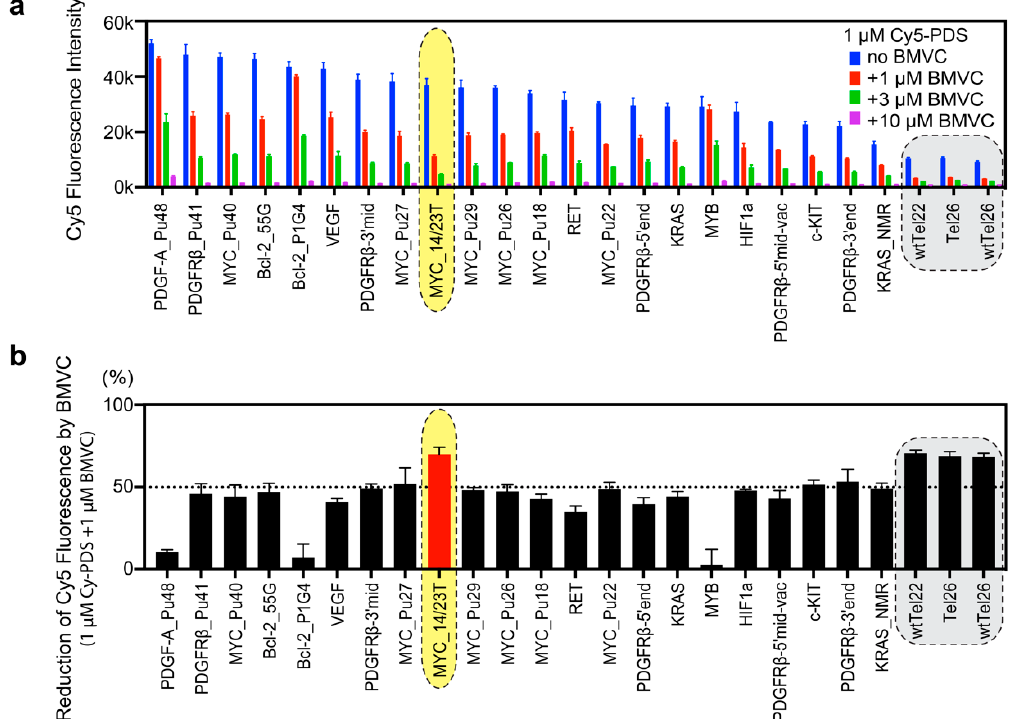
Figure 2. The binding preference of BMVC to known G4 structures. Among the known G4 structures, BMVC prefers to bind to MYC_14/23T, 5 ′ -TGAGGGTGGGTAGGGTGGGTAA-3 ′ (highlighted by yellow shade). Telomeric sequences are known to form nonparallel structures [42–46] and are poorly bound by Cy5-PDS (shaded in gray). ( a ) The competition microarray experiments showing dose-dependent inhibitory effects of BMVC on the binding of Cy5-PDS to various known G4 structures. The G4 sequences are shown in Table 1. n = 2 to 20 independent measurements. Error bars represent mean ± SD. ( b ) BMVC has different inhibitory effects on the binding of Cy5-PDS to the known G4 structures at the equal molar concentration (1 µM). n = 2 to 20 independent measurements. Error bars represent mean ± SD.